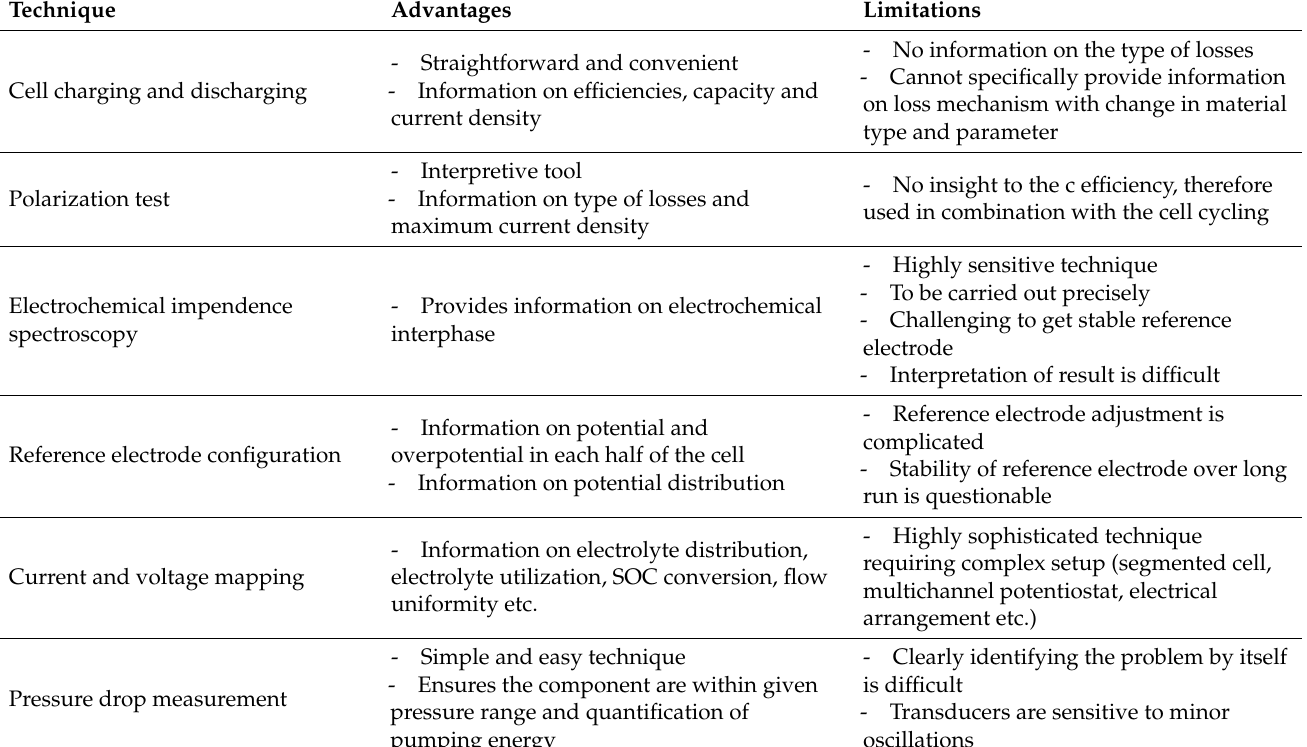
Table 4. In situ diagnostic tools with advantages and